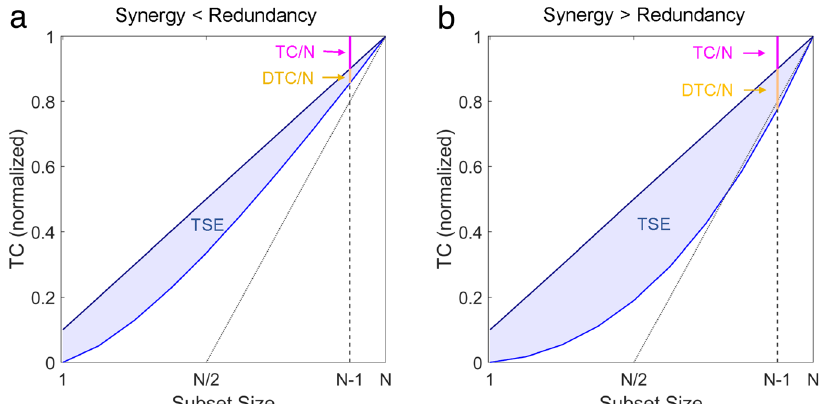
Fig. 1 Understanding O-information in the context of the TSE complexity. The TSE complexity provides a system-wide summary statistic of how integrated the system is at every scale. The O-information can be understood as measuring how sensitive the global integration is to the removal of single elements (on average). a The panel shows a TSE curve for a low-synergy system: TC( X )/ N > DTC( X )/ N , so Ω ( X ) > 0. The erasure of any single element, on average, does not change the overall integration of the remaining ( N − 1) elements much more than would be expected in the null case. b The panel shows the case where TC( X )/ N < DTC( X )/ N , so Ω ( X ) < 0 and the system is synergy dominated. Intuitively, this can be understood by recognizing that, on average, the removal of any of the N elements causes a large decrease in the integration among the remaining ( N − 1)